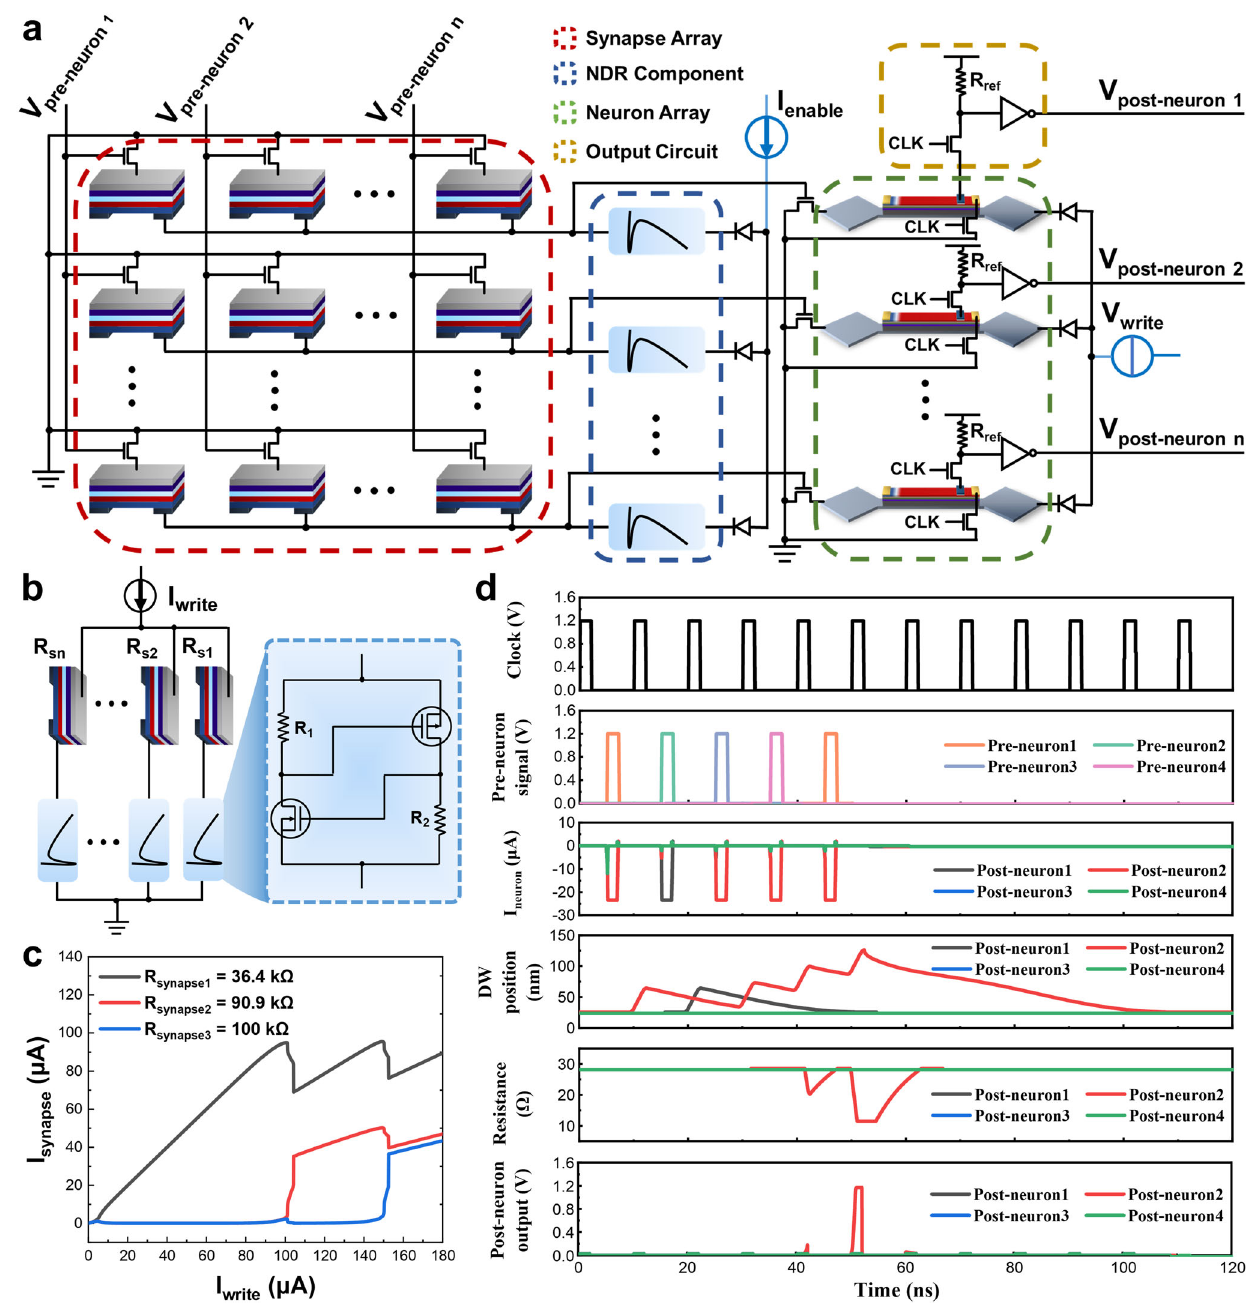
Fig.5|WTAwithintegratednegativedifferentialresistancecharacteristicsand spike neural circuit. a Basic structure of the spike neural circuit based on a synapses array, NDR devices array, LIFneurons array and output circuit. b Winner-